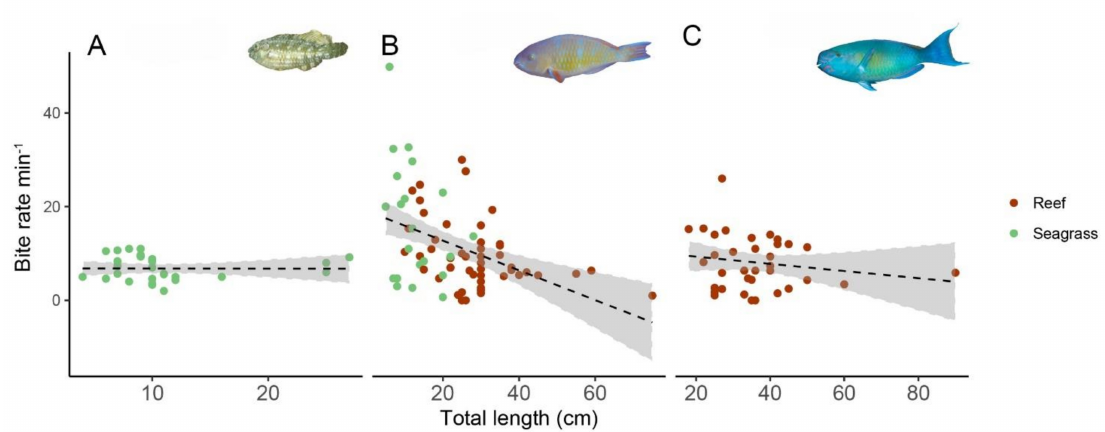
Figure 3. Bite rates of ( A ) L. vaigiensis , ( B ) S. ghobban and ( C ) S. rubroviolaceus as a function of fish size (TL). Shadowed areas indicate a 95% confidence interval and the broken line average bite rate per minute. Each dot represents an individual fish.